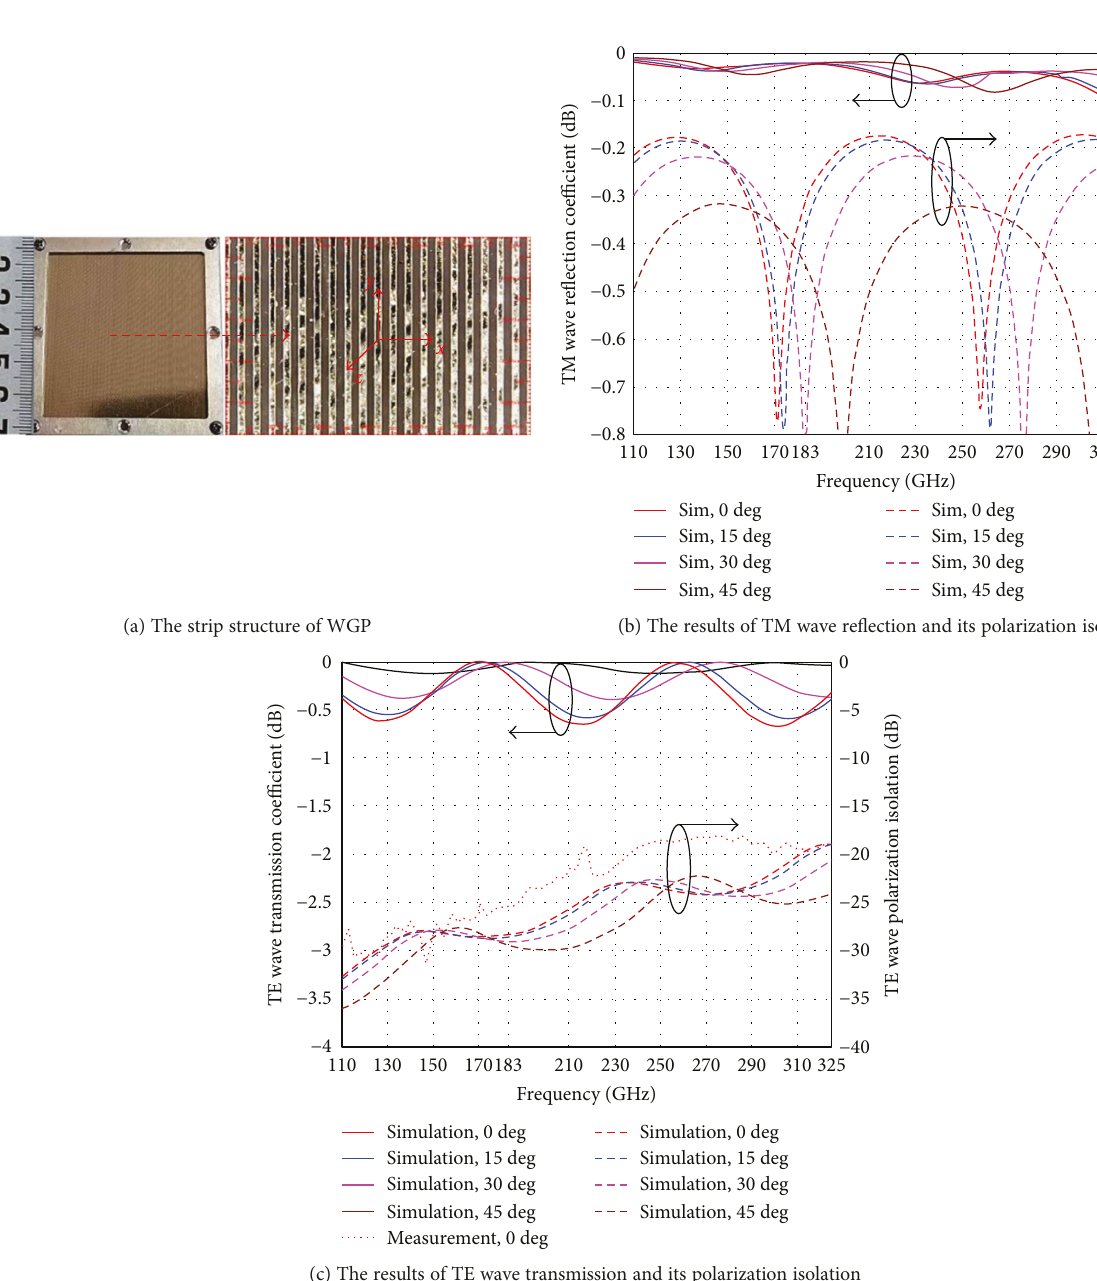
Figure 7: The structure model of WGP and its frequency response curve with di ff erent incidence angles of 0 ° , 15 ° , 30 ° , and 45 ° at TE and TM